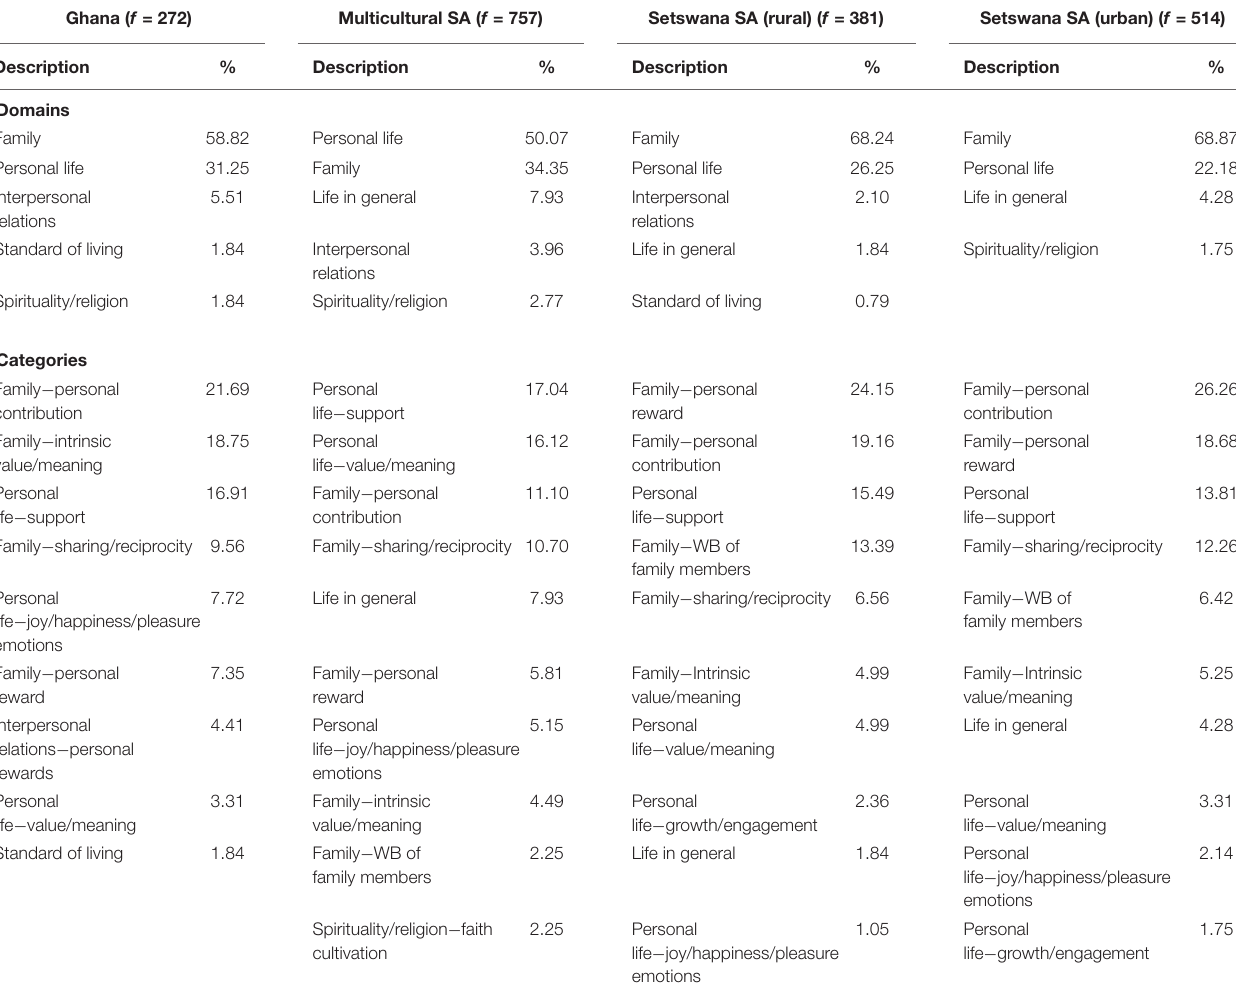
TABLE 3 | Percentages of the most frequent domains and categories mentioned in the motivations for meaning sources in the family domain of life. Ghana ( f = 272) Multicultural SA ( f = 757) Setswana SA (rural) ( f = 381) Setswana SA (urban) ( f =